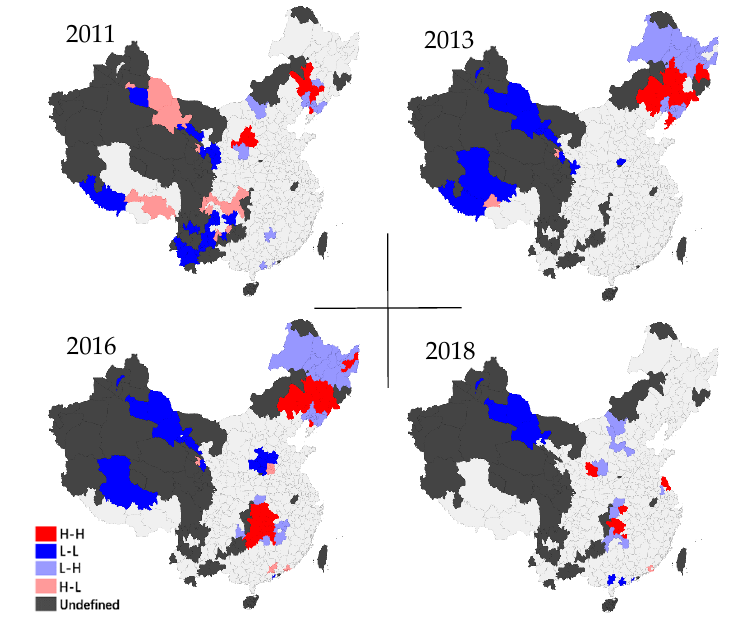
Figure 7. Evolution characteristics of regional spatial patterns of the green land utilization efficiency in Chinese cities.